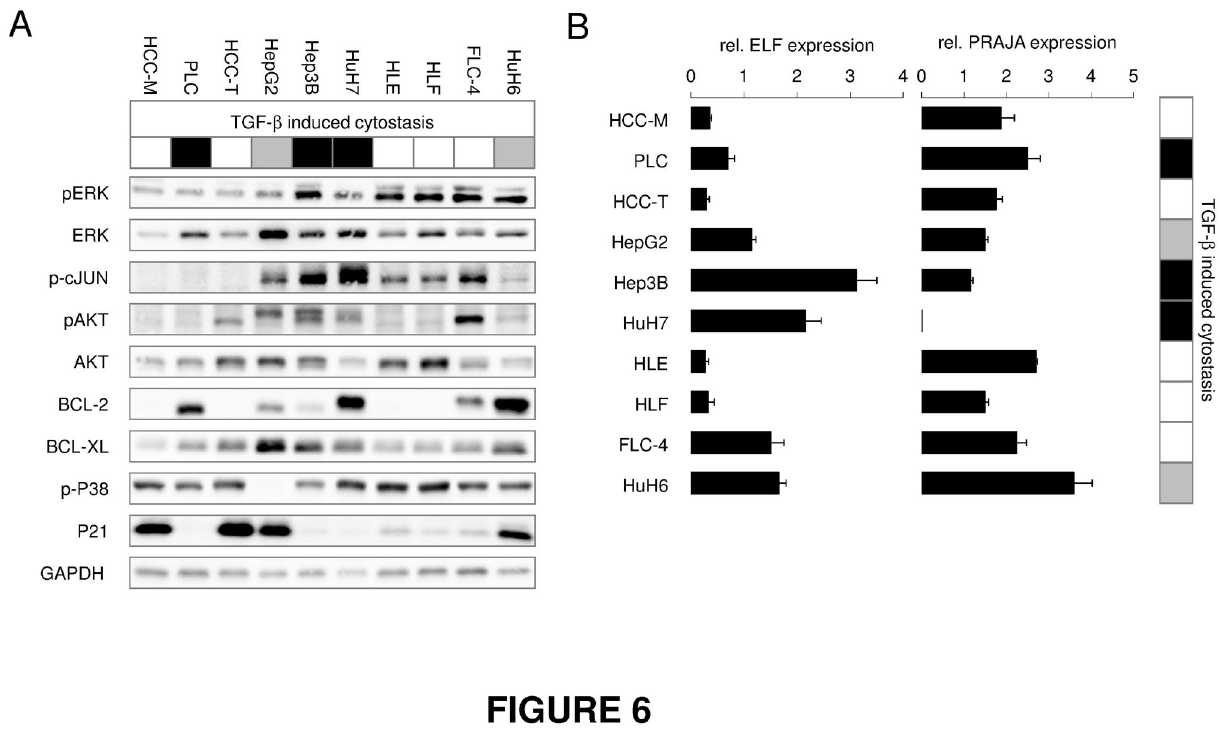
Figure 6. Endogenous expression of survival factors and Smad3 signaling modulators PRAJA and ELF in HCC cells. HCC cell lines were cultured in starvation medium for 24 h. (A) Western blot analysis was performed to evaluate expression levels of Akt, Bcl-2, Bcl-XL, p21 and GAPDH as loading control. Additionally, phosphorylation levels of ERK, c-Jun, Akt (lower band) and p38 were detected. (B) Basal PRAJA and ELF mRNA levels were quantified by Real time PCR analysis using rS18 as reference gene. Tables in (A) and (B) highlight cell lines responding to TGF-β with cell death and growth arrest in black. Cells which mainly show an inhibition of proliferation are marked as